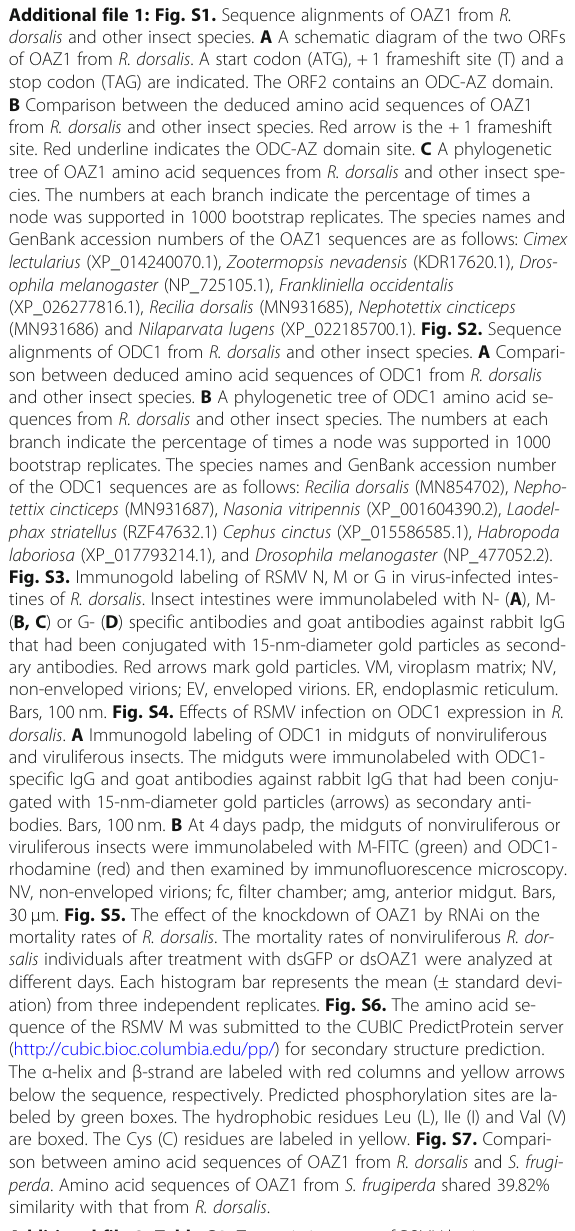
Additional file 2: Table S1. Transmission rates of RSMV by insect vectors that were treated with DFMO or